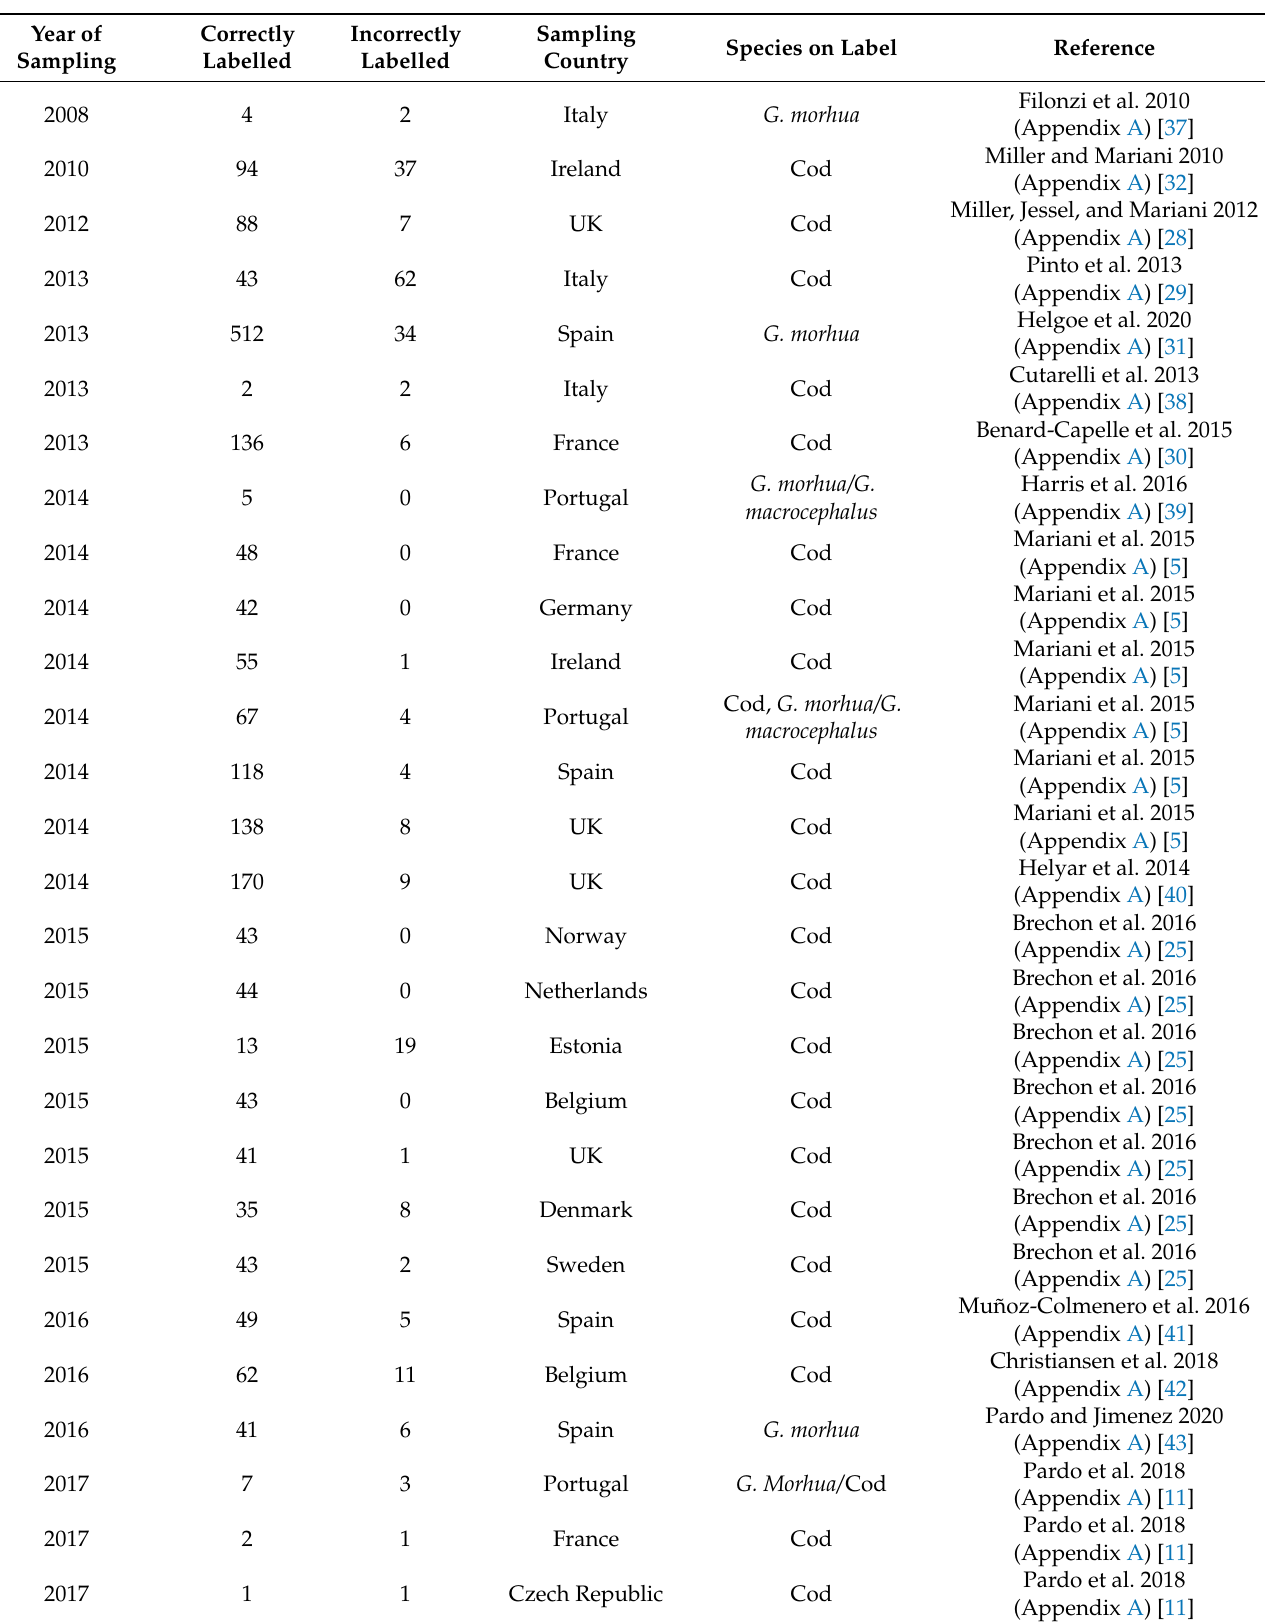
Table 2. Number of mislabeled cod within the EU from literature. Year of sampling, number of correctly and incorrectly labelled samples, country, species reported on the label, and the published reference are